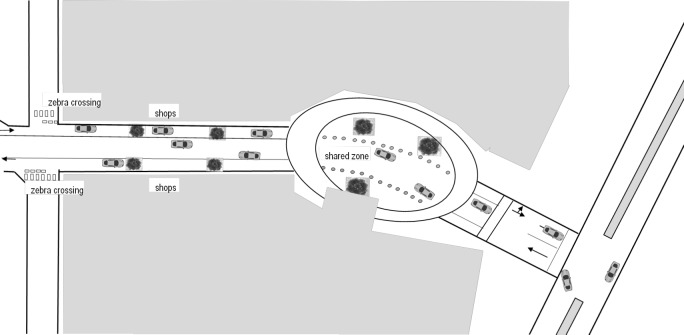
The shared zone/ road runs through the centre of a shopping mall in two directions.It is clearly marked as a reduced speed zone (<10km/h) and pedestrians have right of way. It is a small area that is designated for crossing that has a moderate amount of foot and motorized traffic. The road is marked with bollards and is very closely locate to multiple zebra crossings, acted as the control crossing area.